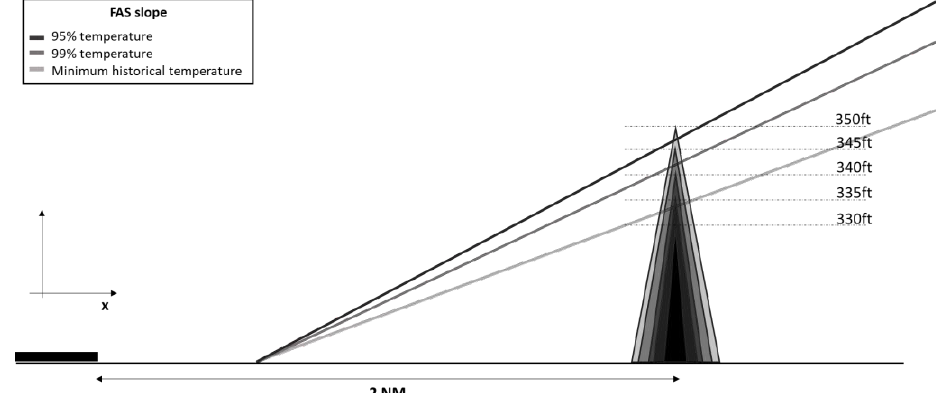
Figure 11. FAS slope with obstacles at the same position but different heights.